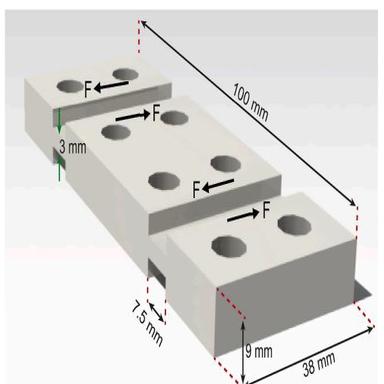
Geometrical characteristics and dimensions of the specimen in shear test.